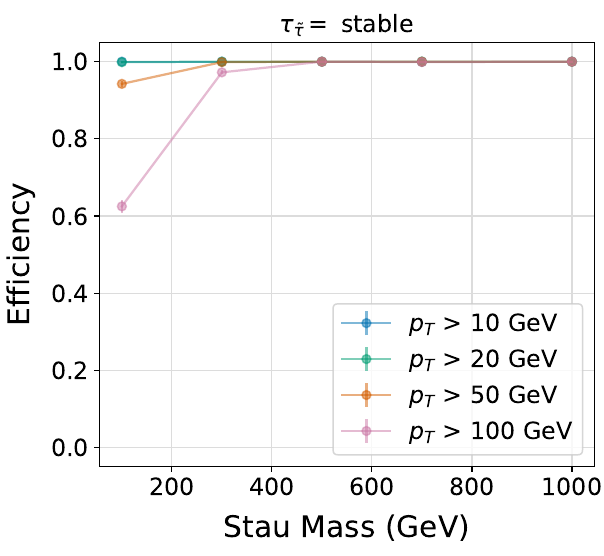
Figure 33. Stau efficiency for a variety of minimum tracker p T values. Efficiency is shown as a function of stau mass for a stable lifetime and minimum L